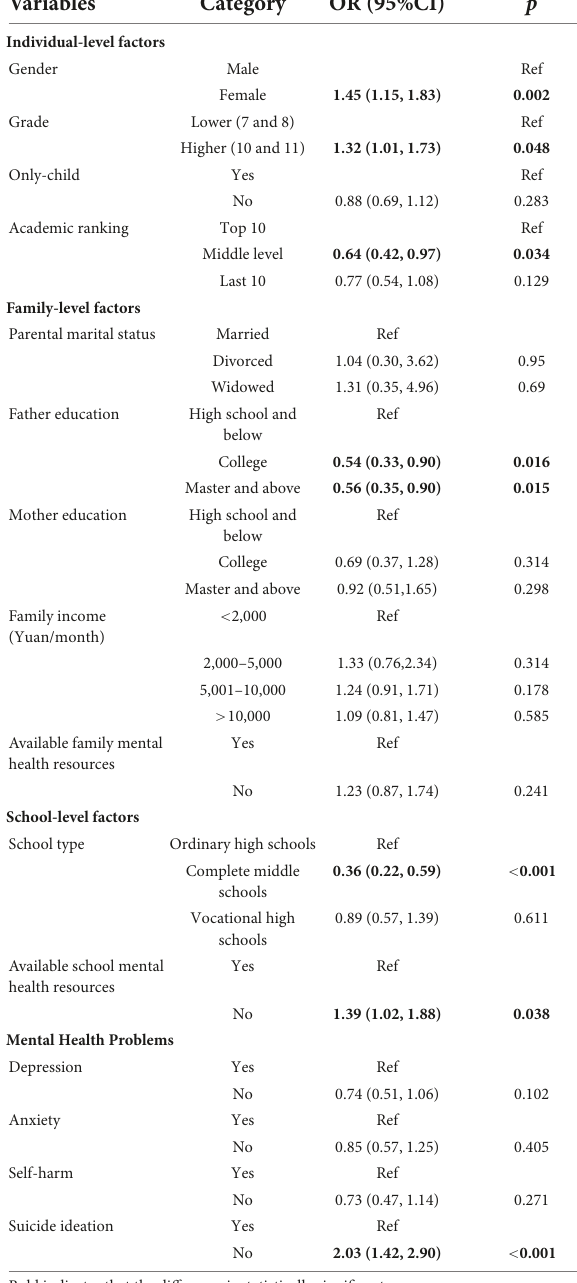
TABLE 5 Multivariate logistic regression of influencing factors of formal help-seeking